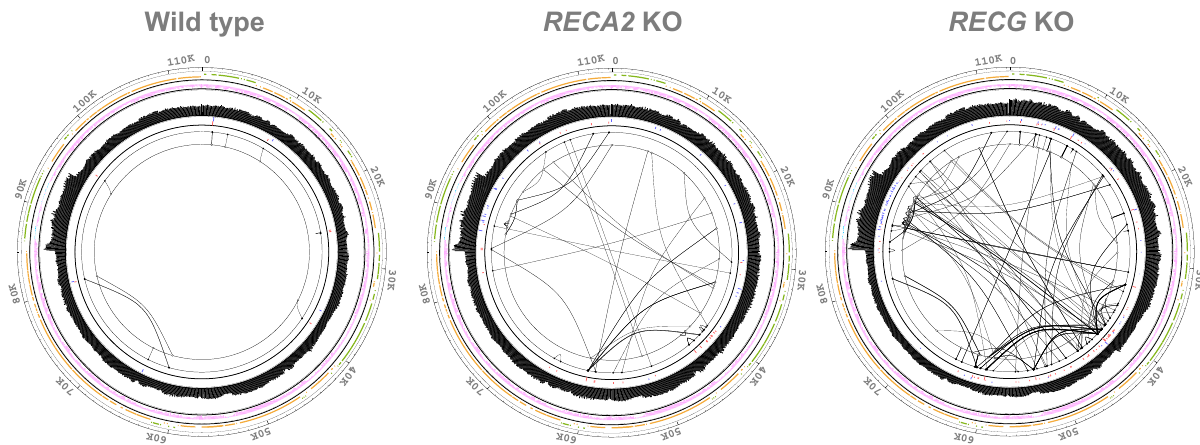
Fig. 5 Links of junction reads in chloroplast DNA. Rearrangements identi fi ed by junction reads are shown as links on the cpDNA map along with mapping depth. Detailed explanation of the tracks is found in Supplementary Fig. 8. One copy of the inverted repeats